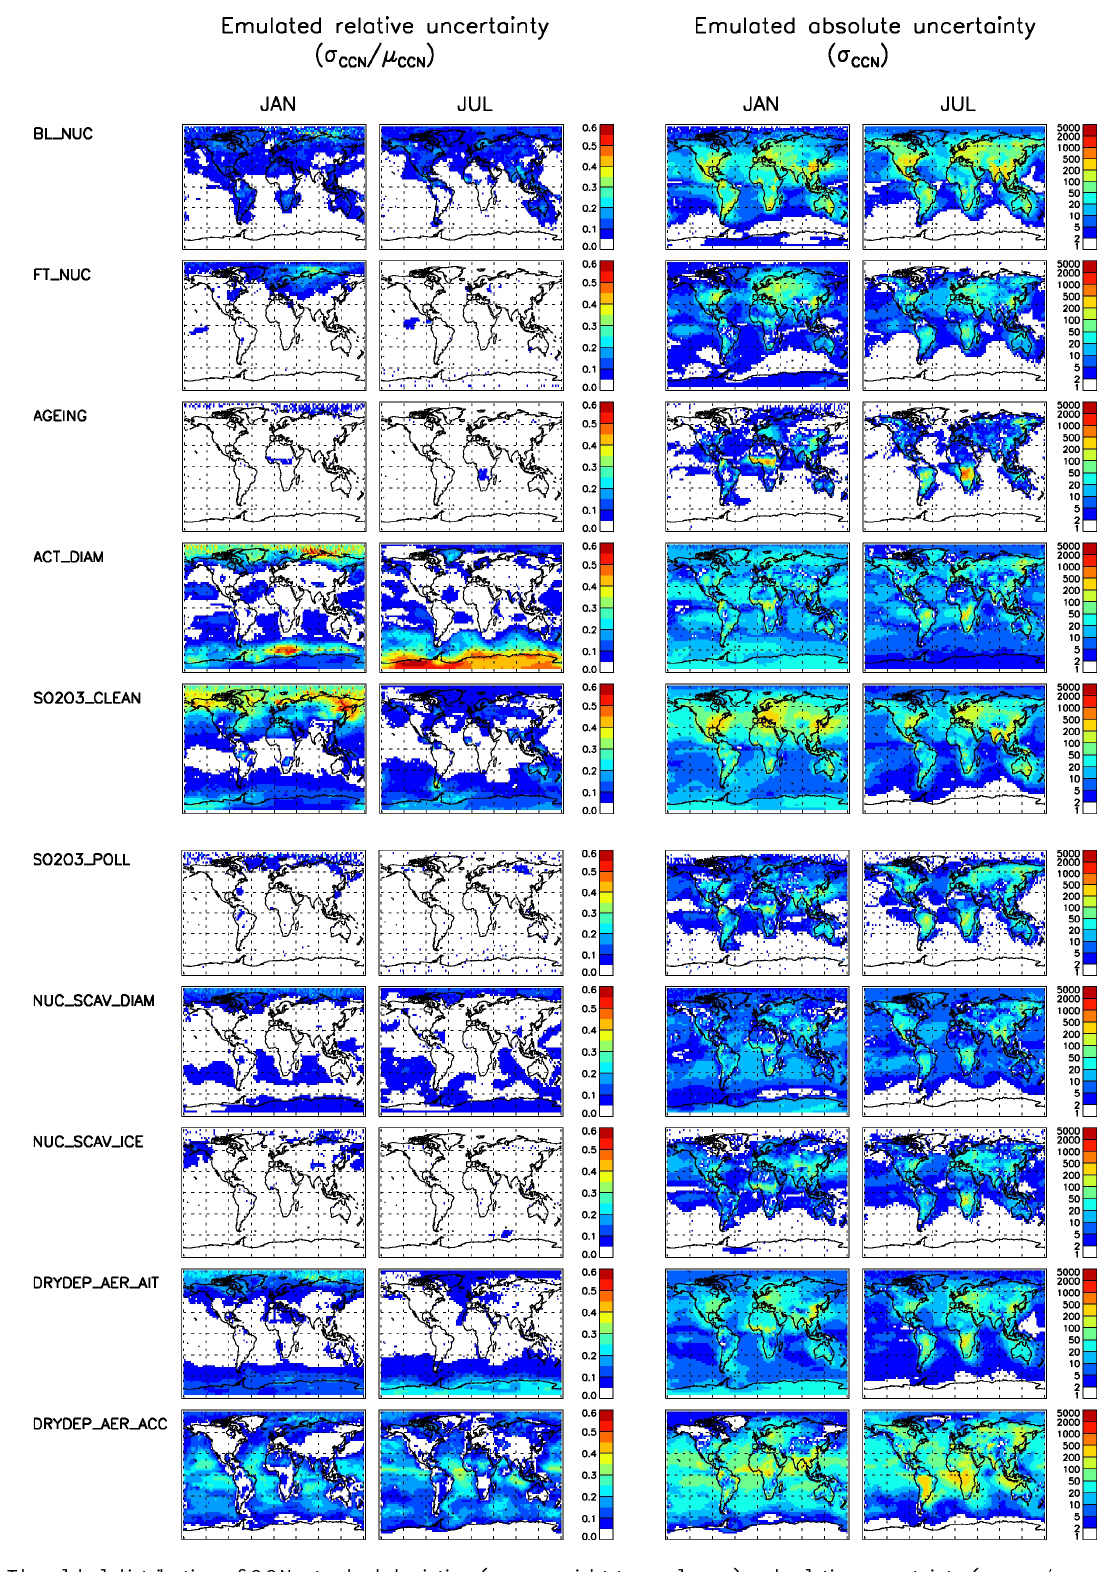
Fig. 7. The global distribution of CCN standard deviation ( σ CCN ,i , right two columns) and relative uncertainty ( σ CCN ,i /µ CCN , left two columns) for each of the 28 parameters i in Table 1 for January and July. Results are shown for the 915hPa model level. Each map is generated from the results of 8192 independent emulators (the total number of grid boxes on one level of the model).